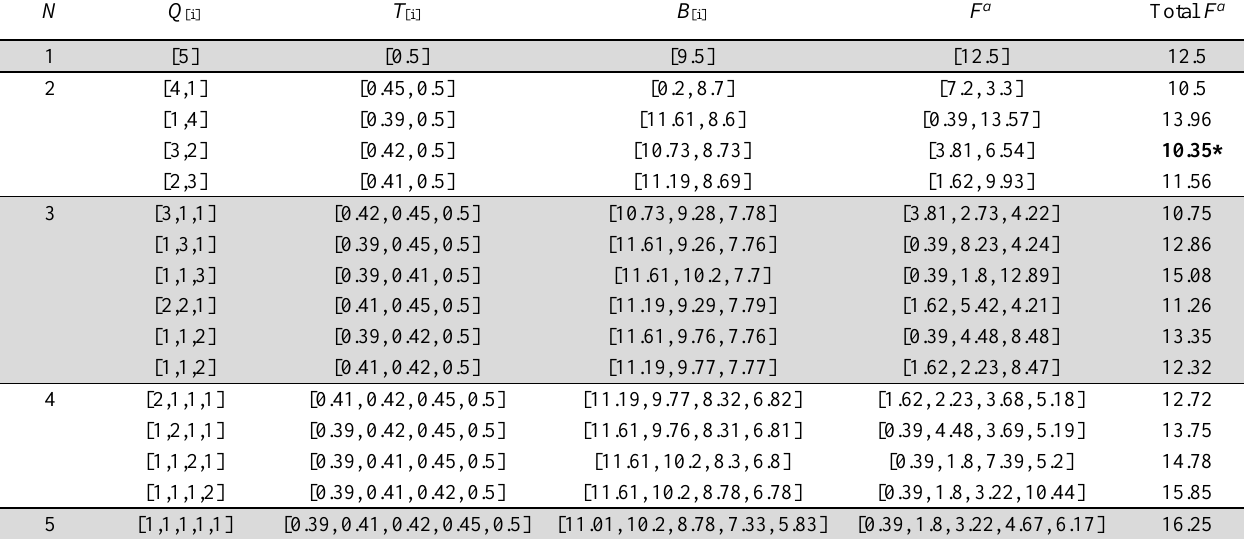
Table 3 Testing Results of the